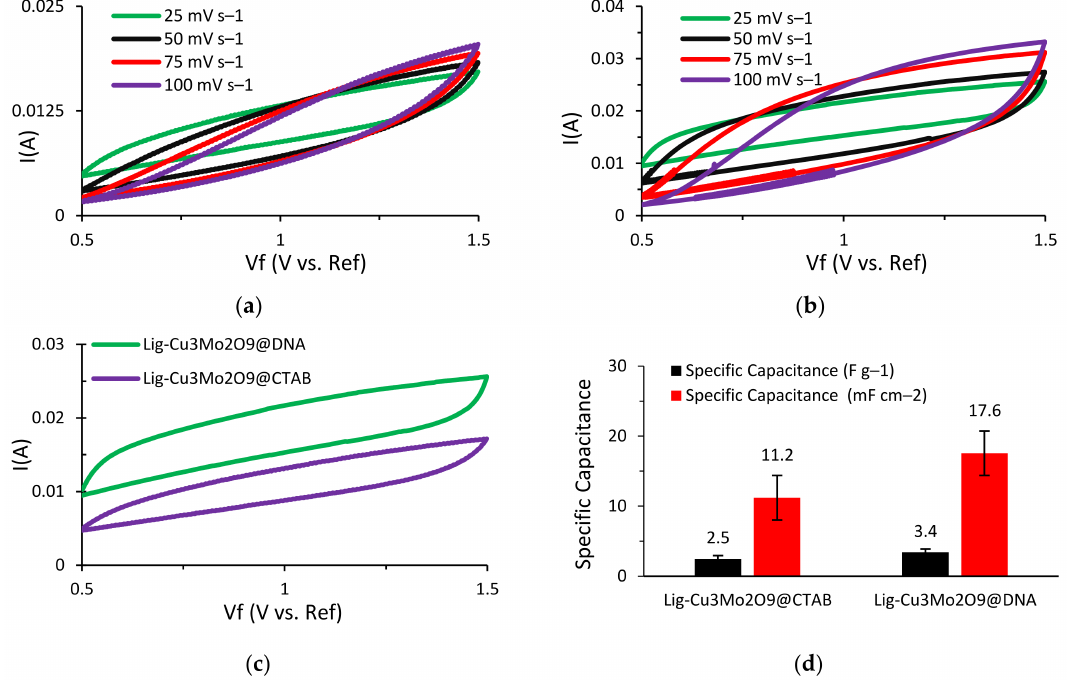
Figure 6. CV curves at various scan rates for ( a ) Al/Lig-Cu 3 Mo 2 O 9 @CTAB supercapacitor; ( b ) Al/ Lig-Cu 3 Mo 2 O 9 @DNA supercapacitor; ( c ) CV plots of Al/Lig-Cu 3 Mo 2 O 9 @CTAB and Al/Lig- Cu 3 Mo 2 O 9 @DNA at 25 mV s − 1 ; ( d ) histogram comparing the specific capacitance values obtained from the CV